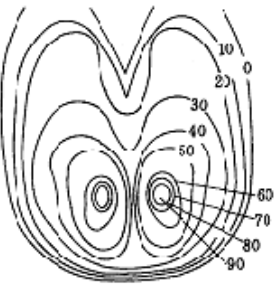
Fig. 3 Sitting gesture pressure distribution